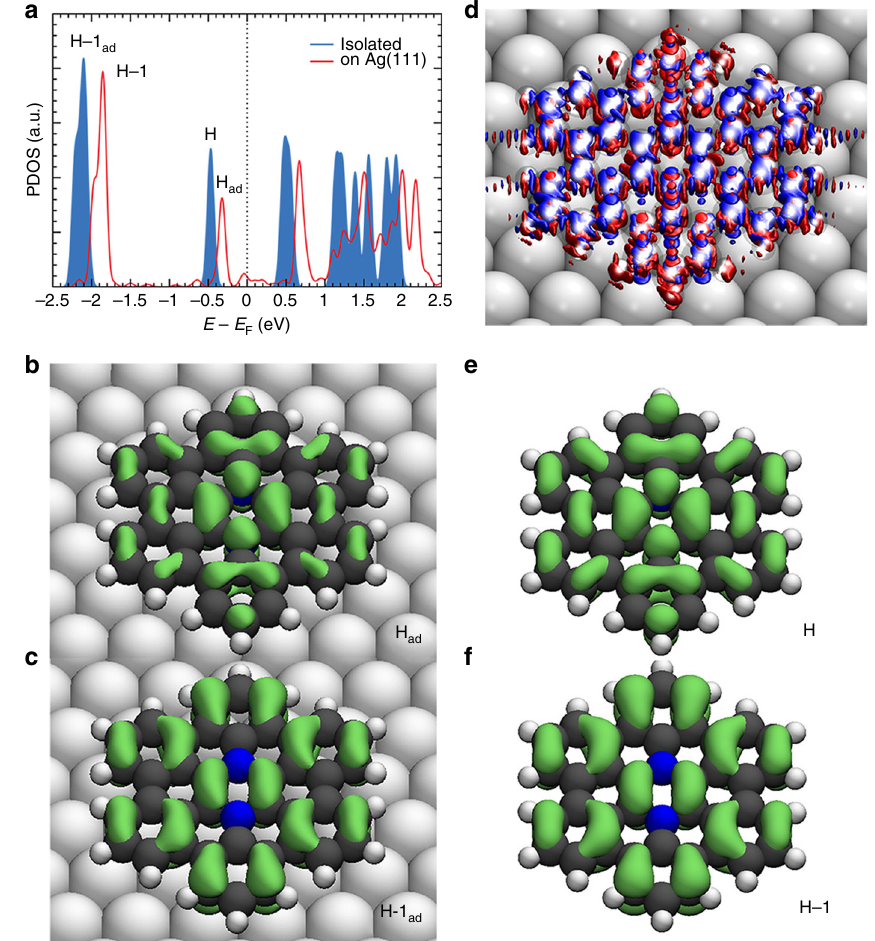
Fig. 6 DFT electronic structure comparison of the isolated and Ag(111)-supported diaza-HBC 7c . a Projected p z contributions to the density of states of isolated 7c (blue) and on Ag(111). The Fermi energy ( E F ) of the isolated molecule has been arbitrarily de fi ned for comparison. b , c Contribution of the highest occupied molecular orbital H ad (at − 0.32 eV in a ) and ( H-1 ) ad to 7c on Ag(111). d Electron density difference between 7c on Ag(111) and the isolated molecule plus isolated substrate. Red regions represent electron density depletion, whilst blue electron density gain. Atoms are rendered translucent. e , f Highest occupied molecular orbital H and H-1 of isolated 7c . These results suggest that antiaromatic character is preserved on